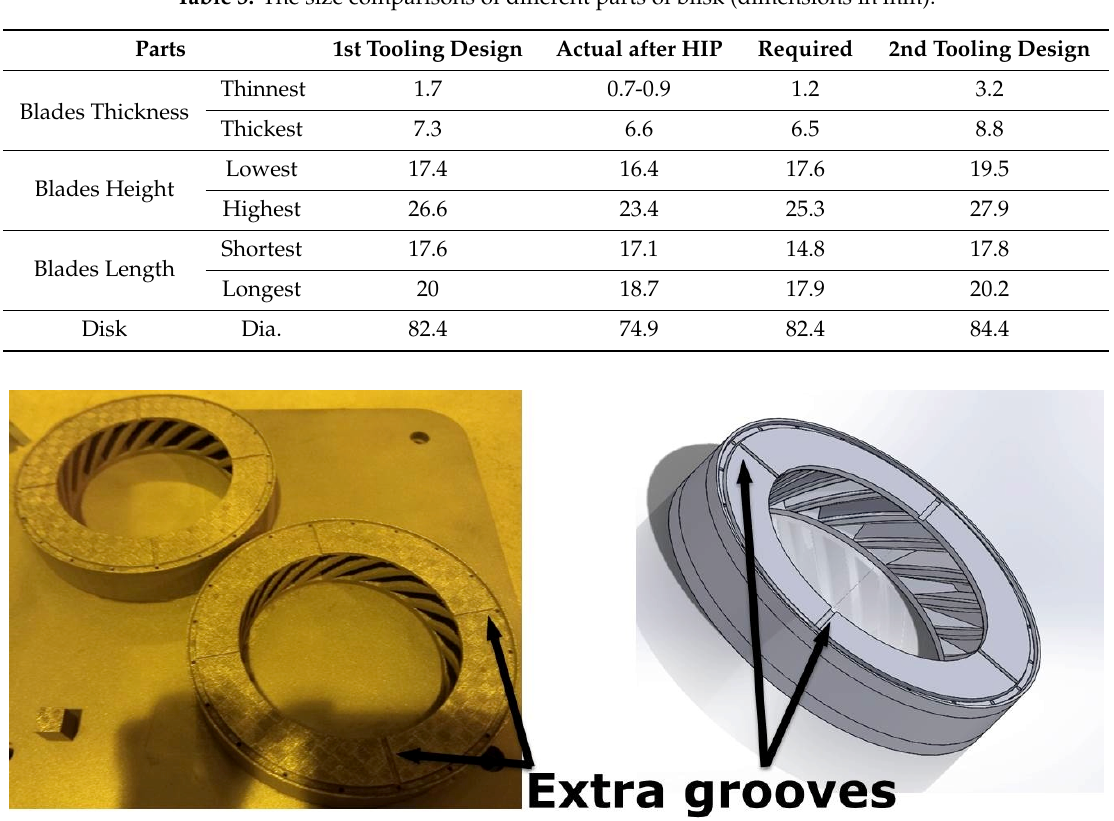
Figure 12. The image and CAD model of second oversized SLM-processed blade tooling.